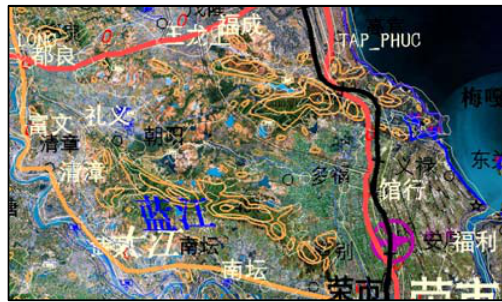
Figure 4. The chart of multi-source data integration